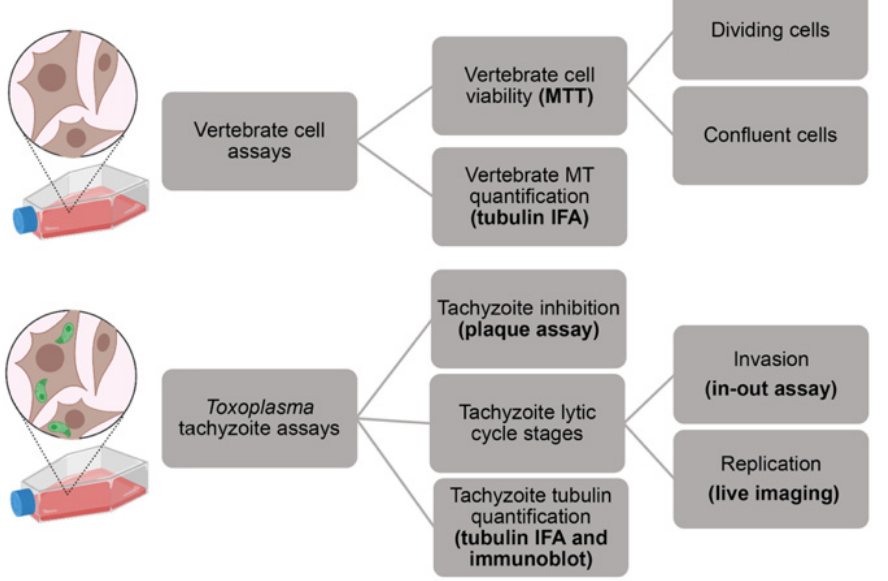
Figure 5. Parasite-selective microtubule-targeting agent testing cascade schematic. Analysis of compound effects on uninfected human fibroblasts capture any deleterious consequences to vertebrate microtubules or other key cellular processes. Assays using Toxoplasma tachyzoites cultured in human fibroblasts delineate drug efficacy and define effects on the lytic-cell stages of invasion and intracellular growth. Quantification of tubulin protein concentration and subpellicular microtubule length distribution identifies direct effects on tubulin and microtubules.